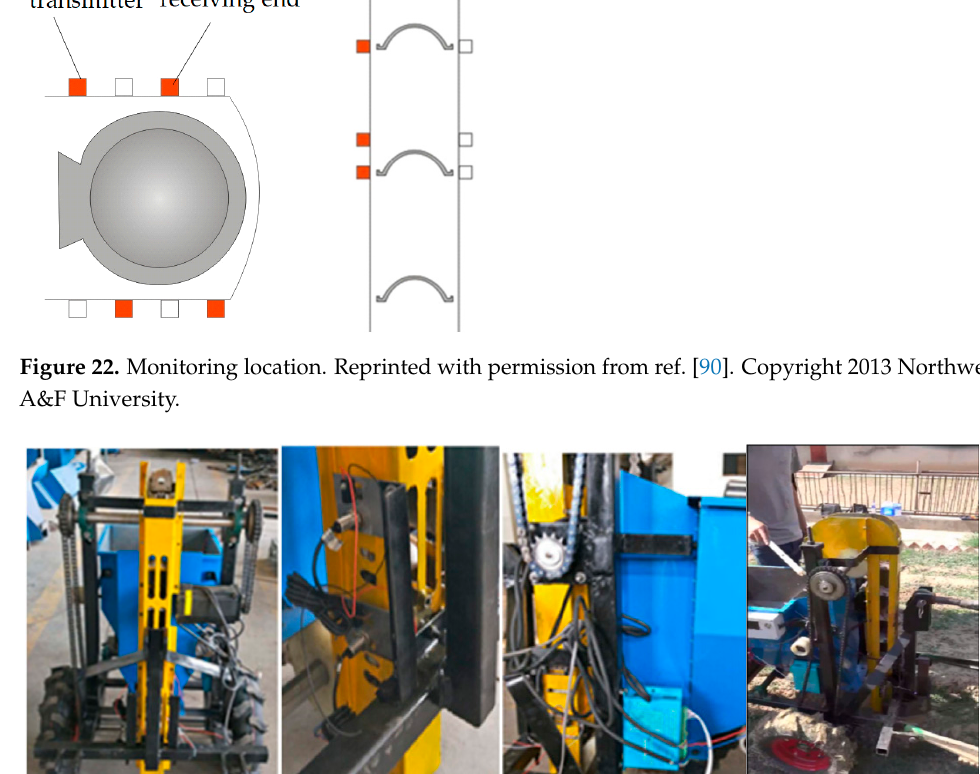
Figure 22. Monitoring location. Reprinted with permission from ref. [90]. Copyright 2013 Northwest A&F University.